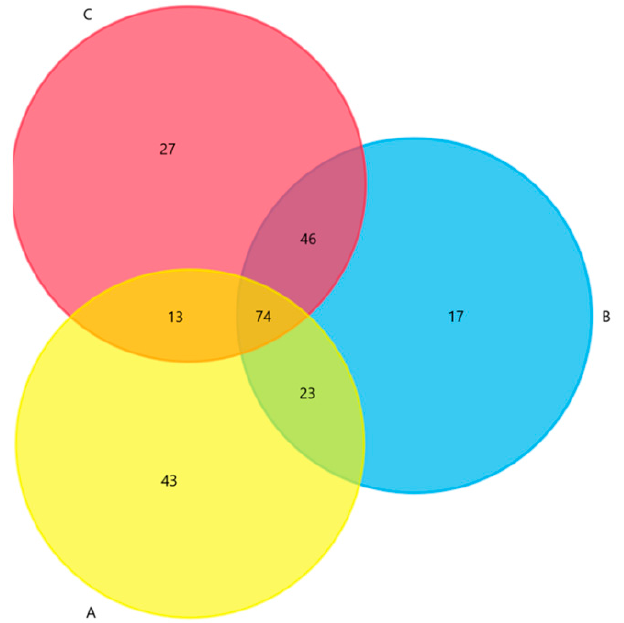
Figure 3. Venn diagram indicating the abundance of shared and dissimilar ARGs in the three types of samples: Three types of samples were fish samples ( A ), water samples ( B ) and soil samples ( C ). There were 366 ARGs in total, 74 of them shared in the three types of samples, 23 of them shared between fish samples and water samples, 46 of them shared between water samples and soil samples and 13 of them shared between fish samples and soil samples.